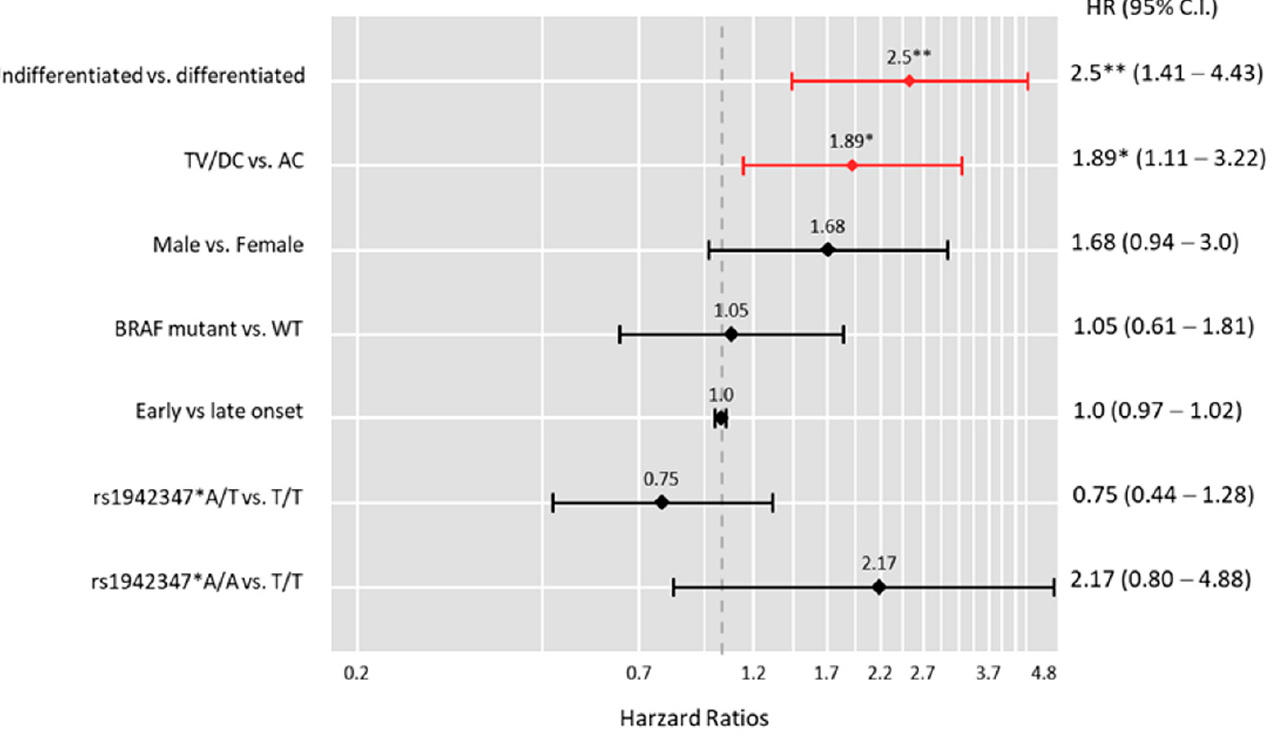
Figure 5. Multivariate Cox regression analysis for overall survival. * p = 0.018, ** p = 0.001. TV: transverse colon; DC: descending colon; AC: ascending colon; WT: wild type. Hazards ratios (HRs) and 95% confidence intervals (CIs) are reported.